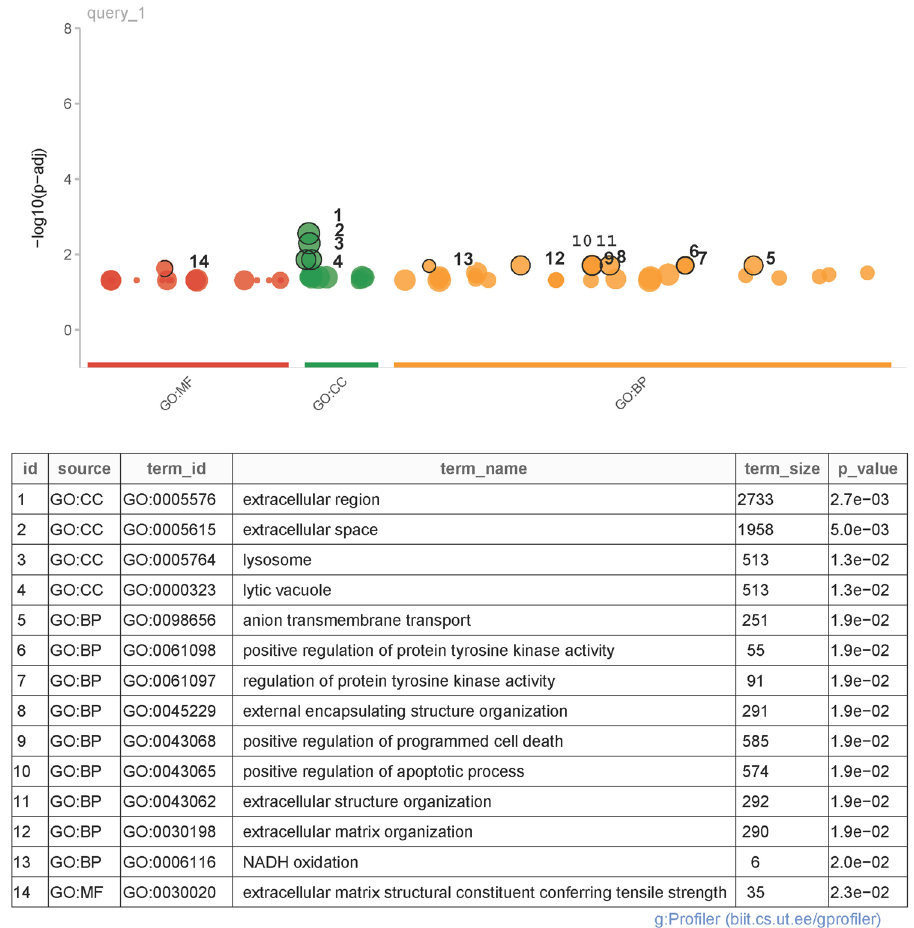
Figure 1. Significant GO terms output by gprofiler2 (only top 14 terms are shown here; see Supplementary Table S3 for the full list). The upper plot is a graphical visualization of the bottom table. The numbers in the plot correspond to the id’s in the table; source = GO categories ( BP biological process, CC cellular component, MF molecular function), term_size number of genes that are annotated to the term, p_value FDR-adjusted